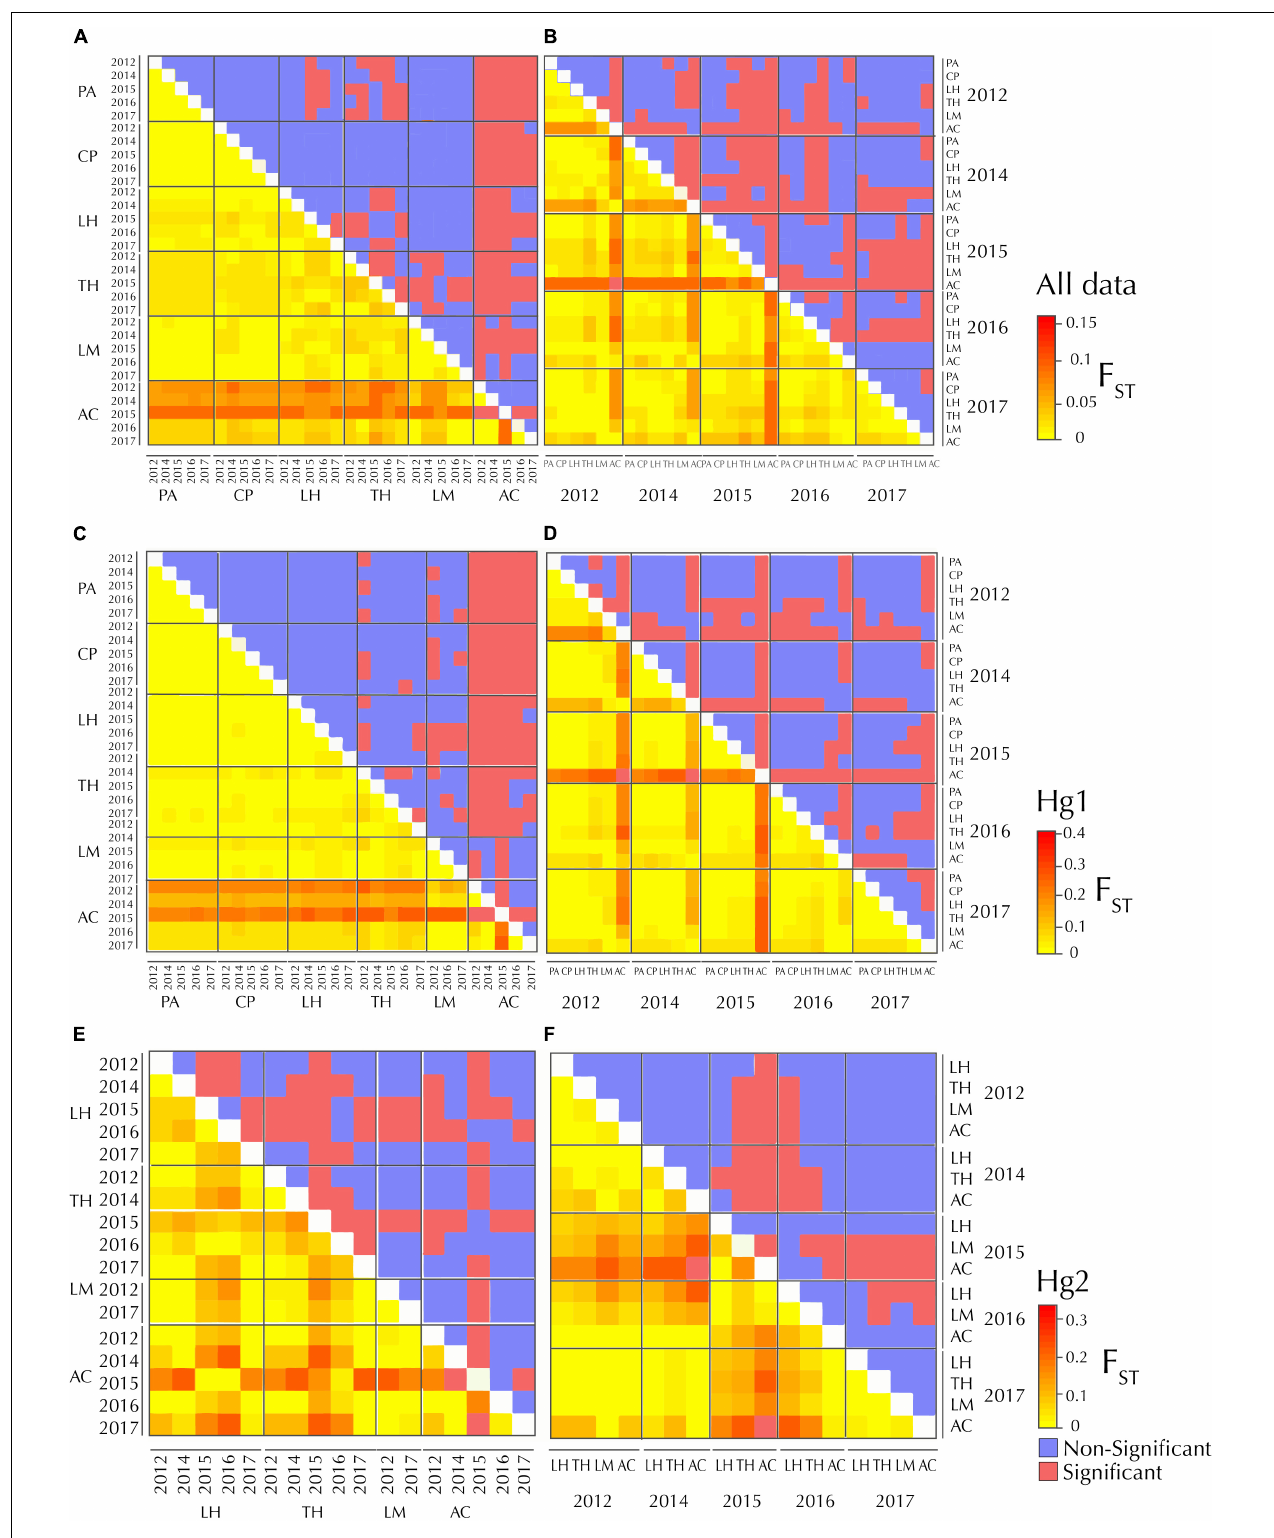
FIGURE 2 | F ST heatmaps between sites (left panels) and years (right panels), respectively in Pyura chilensis. Figure shows the representation of the same matrix, (A) with populations sorted by geographic location and (B) sorted by year for the complete dataset (A,B) , Hg1 (C,D) and Hg2 (E,F) . Lower diagonals display F ST values. Upper diagonals show the significance of the F ST values (after FDR correction), in red significant values and in blue non-significant values.